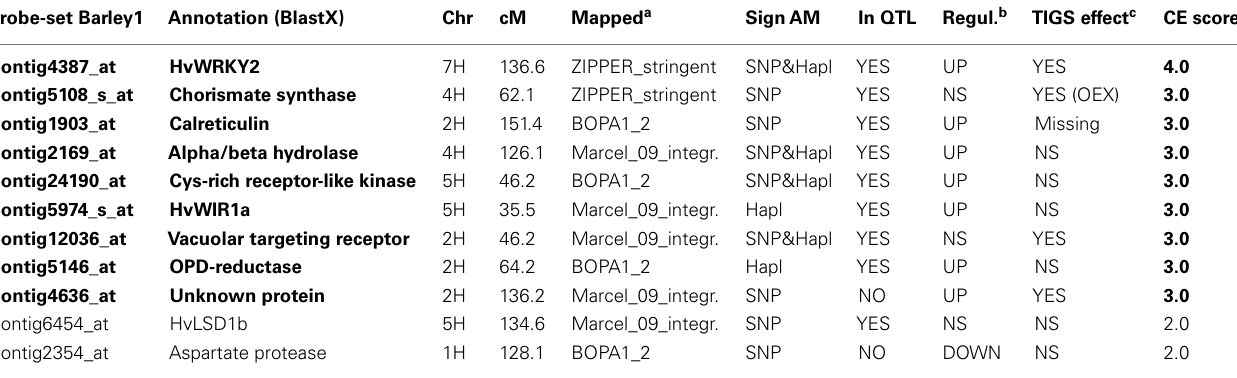
Table 5 | Converging evidence for CGs associated with resistance to Bgh